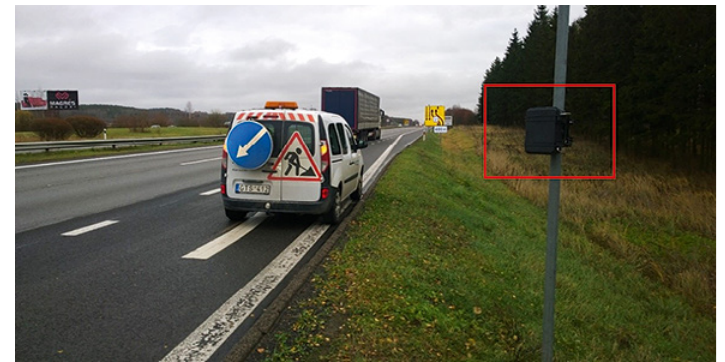
Figure 1. Traffic data collection